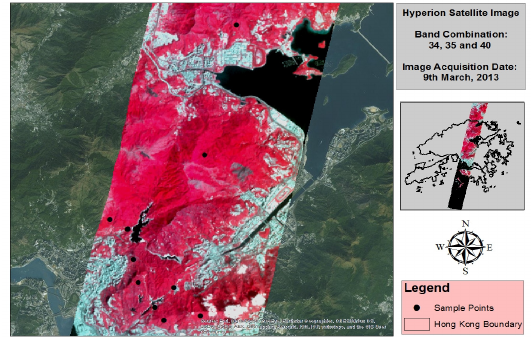
Figure 1: Hyperion Image of Hong Kong